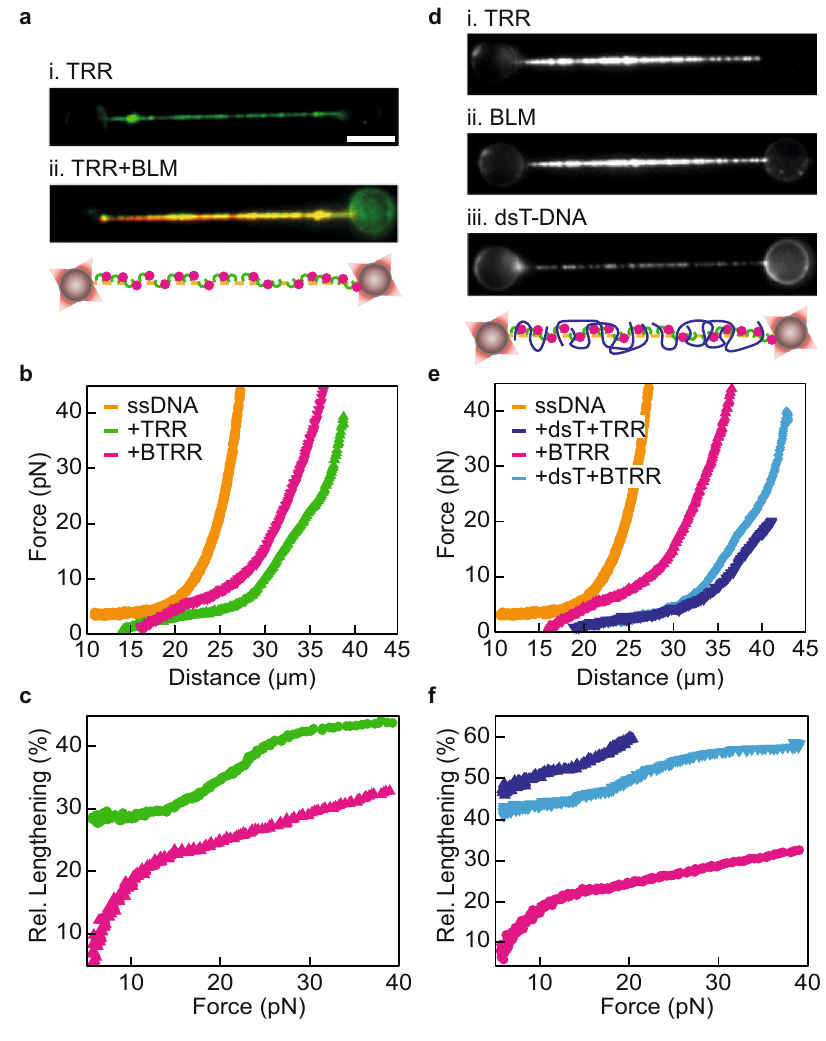
Fig. 6 BLM alters the fl exibility of the TRR-ssDNA gate. a Representative fl uorescence images (from N ≥ 10) of TRR-ssDNA (i) and BTRR-ssDNA (ii), visualized using mCherry/SNAP649 fl uorescence (green/red), respectively. A schematic representation of BTRR complexes bound to ssDNA is shown underneath. The scale bar represents 5 µ m, and applies to all snapshots. b Representative FD-curves (from N ≥ 10) of TRR-ssDNA (green) and BTRR- ssDNA (pink). For reference, the FD-curve of bare ssDNA is shown in orange. c ‘ Subtraction plots ’ showing the relative (rel.) lengthening for TRR-ssDNA (green) and BTRR-ssDNA (pink) compared to bare ssDNA. Plots were generated from the FD-curves shown in panel ( b ). d Representative fl uorescence images (from N ≥ 5) of BTRR-ssDNA bound by dsT-DNA. TRR and BLM were visualized using mCherry (i) and SNAP649 (ii) fl uorescence, while dsT-DNA was stained with intercalator dye (iii). A schematic representation is shown below. e Representative FD-curves (from N ≥ 5) of BTRR-ssDNA in the absence (pink) and presence (light blue) of dsT-DNA. For reference, the FD-curves of bare ssDNA (orange) and TRR-ssDNA bound by dsT-DNA (dark blue) are also shown. f ‘ Subtraction plots ’ showing the relative lengthening for dsT-coated TRR-ssDNA (dark blue), BTRR-ssDNA (pink) and dsT-coated BTRR-ssDNA (light blue) compared to bare ssDNA. Plots were generated from the data shown in panel ( e ). Source data are provided as a Source Data fi